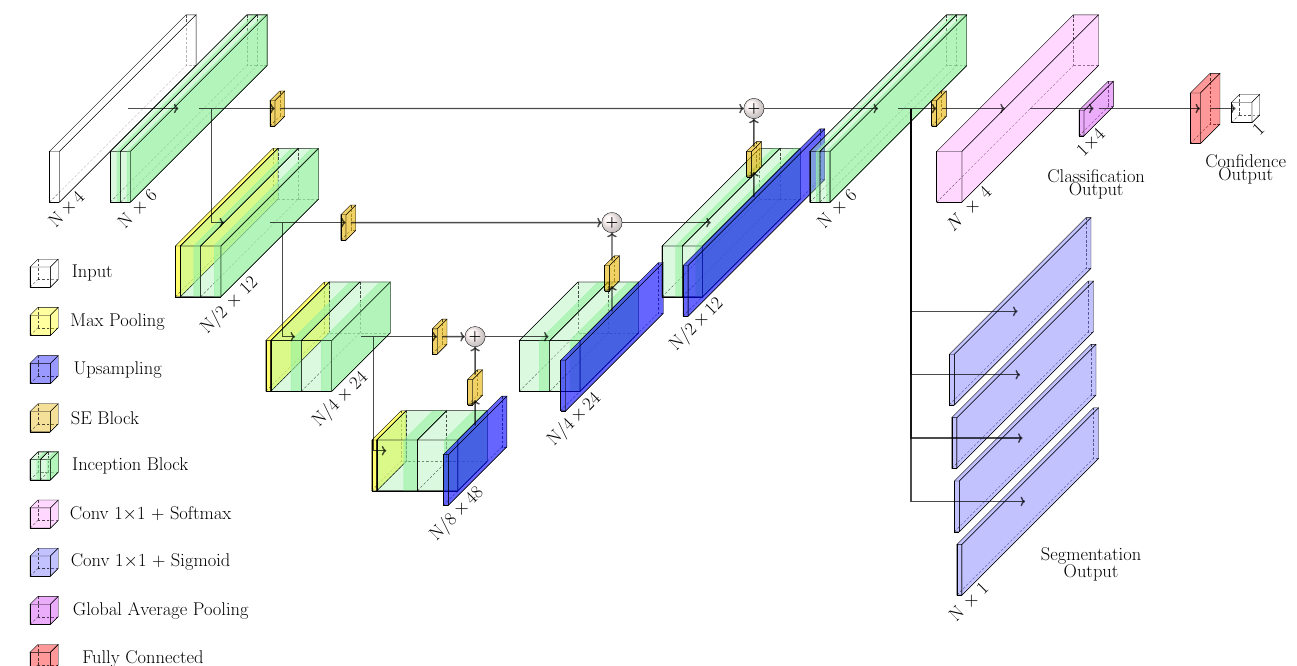
Figure 6. eMTUnet architecture. Some 70 thousand free parameters defined the